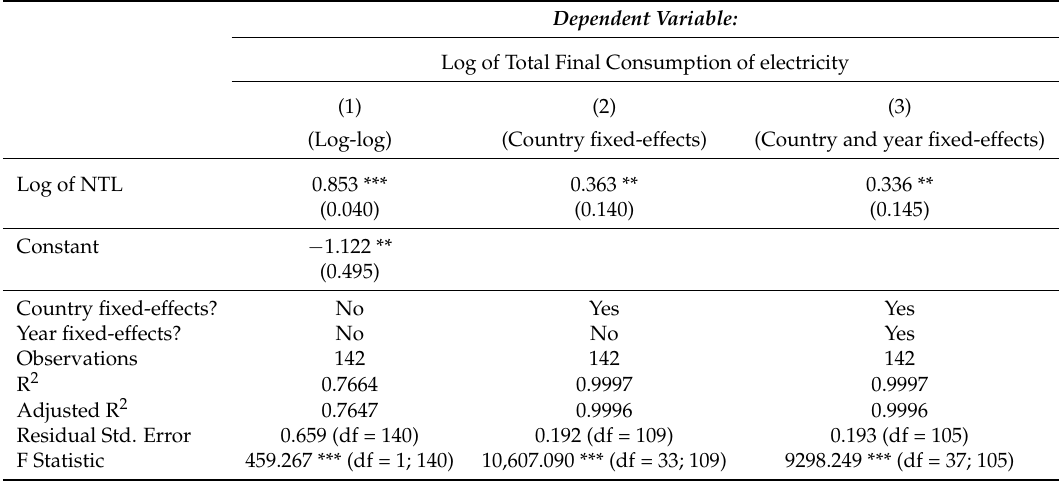
Table A2. Regression for COMMPUB—Lower-middle income countries.